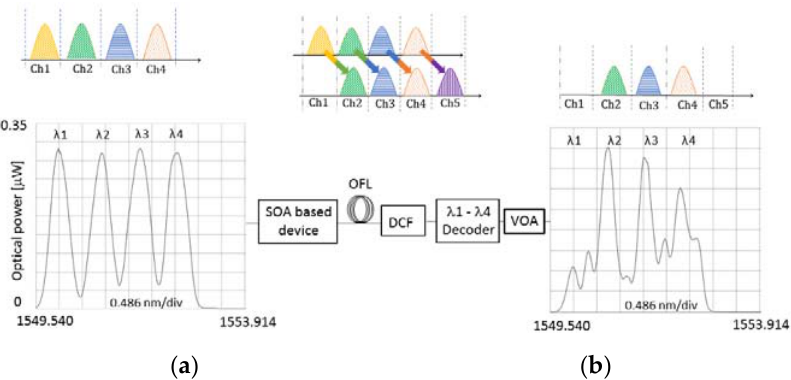
Figure 3. ( a ) Optical spectrum of the 2D-WH / TS OCDMA code based on four λ 1 to λ 4 multi-wavelength picosecond code carries before entering the SOA biased at ~175 mA; ( b ) after passing the SOA followed by dispersion compensated fiber link (DCF) and λ 1 – λ 4 decoder. VOA—variable optical attenuator, OFL—optical fiber lin.